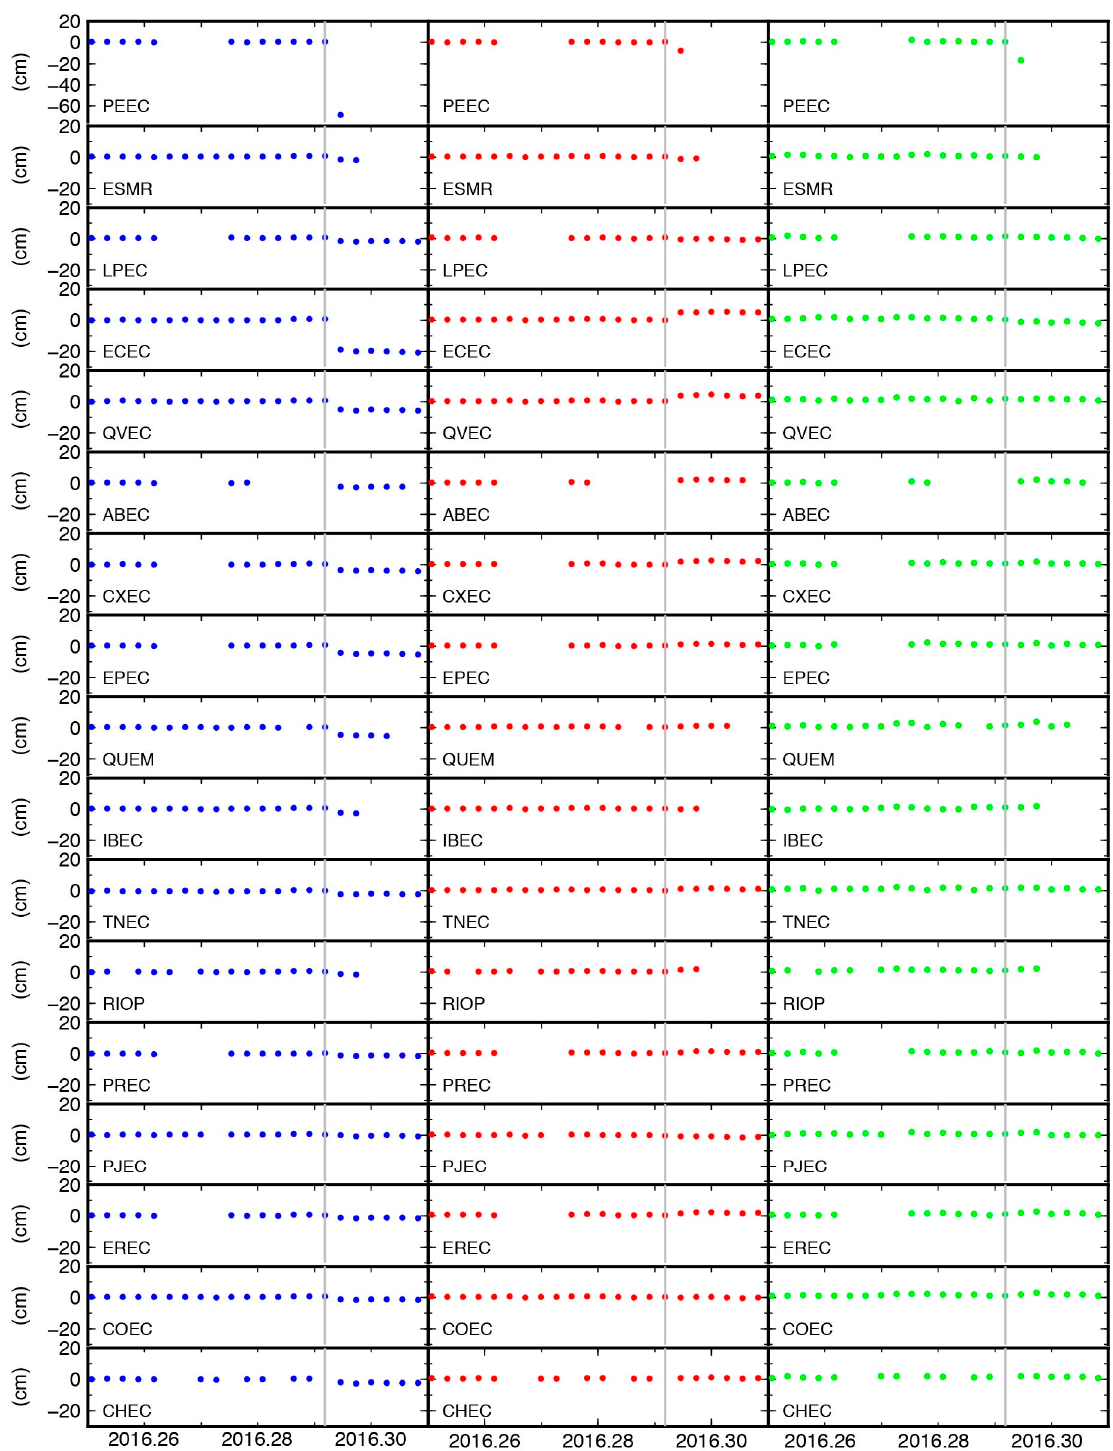
Figure 3. Position time series of the 17 cGPS sites used in this study. For each site, daily positions for components East, North and Up are shown in blue, red, and green, respectively. The vertical grey line represents the date of the Pedernales earthquake (16 April 2016).